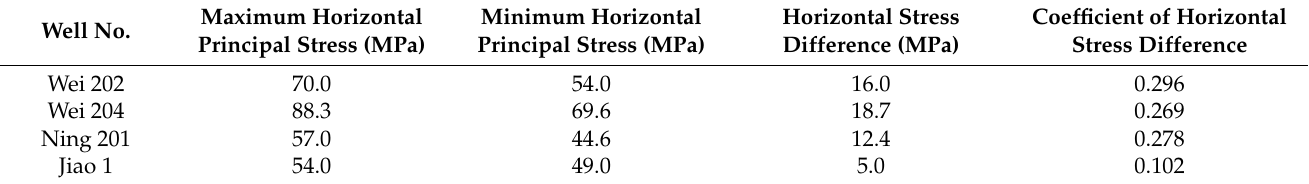
Table 1. Comparison of in-situ stress in typical blocks of Sichuan